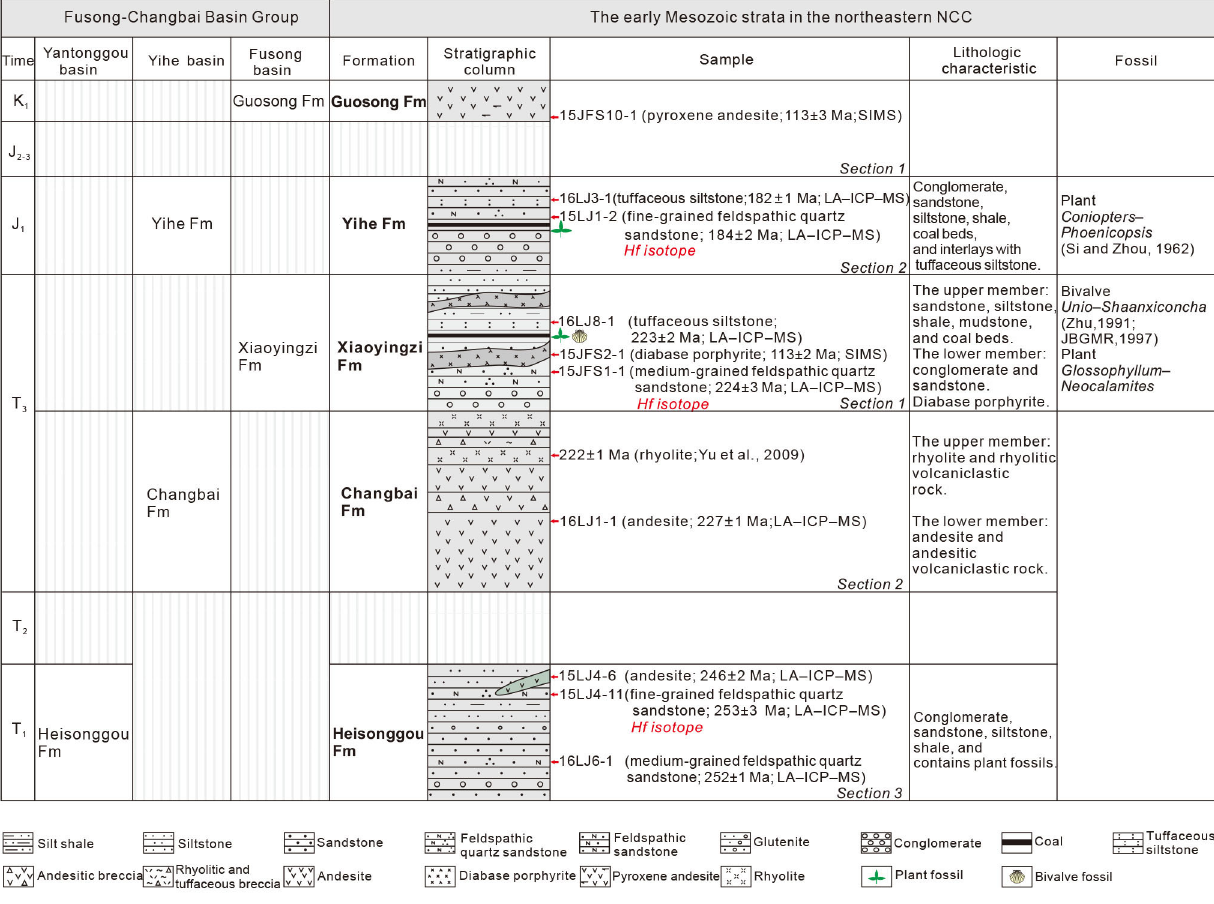
Figure 3. Early Mesozoic stratigraphy of the northeastern NCC, sampling sites, and dating results. The ages refer to the youngest age populations of